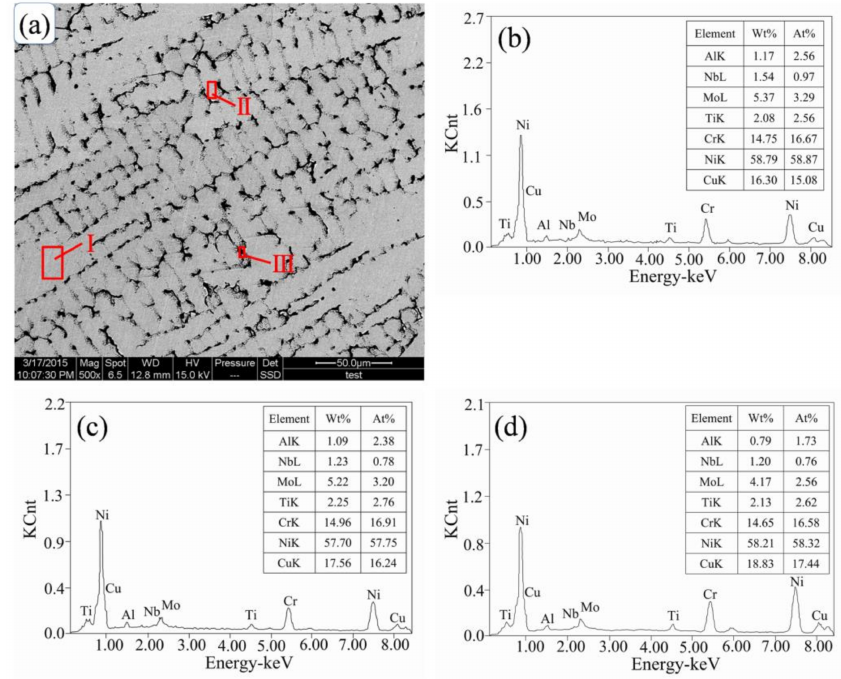
Figure 3. SEM micrographs of heat-treated Ni-Nb1 alloy along with EDS maps: ( a ) SEM micrograph; ( b ) EDS map of zone I in ( a ); ( c ) EDS map of zone II in ( a ); ( d ) EDS map of zone III in ( a